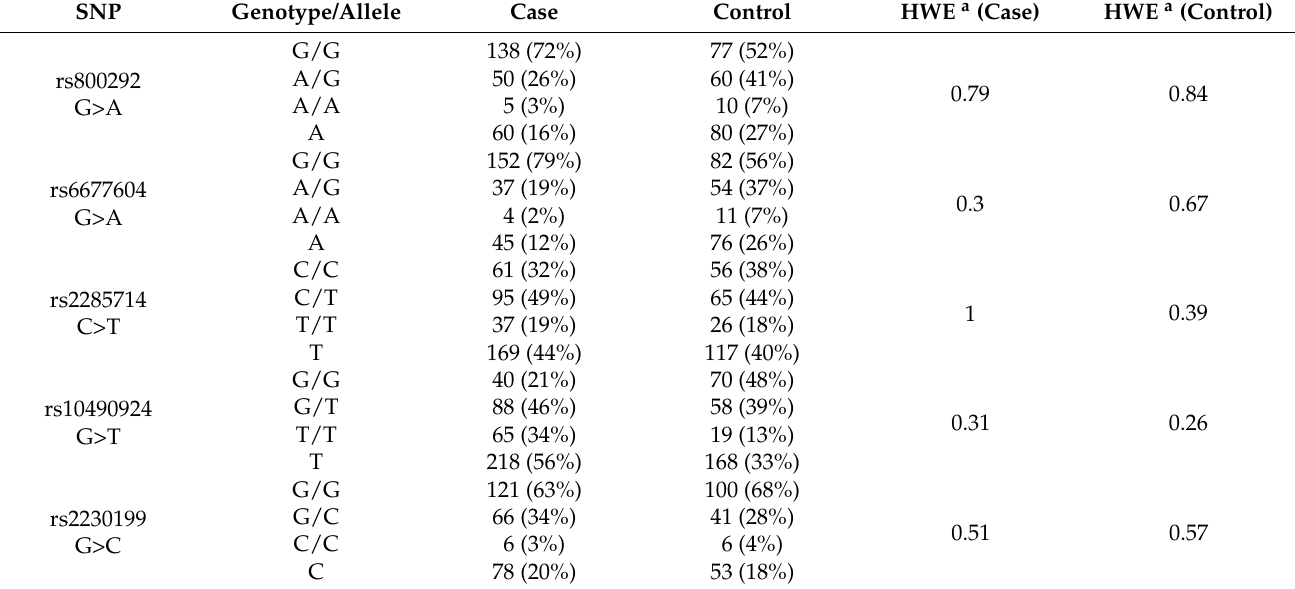
Table 3. Allele and genotype frequencies in the nAMD and control groups in Western Siberia cohort.